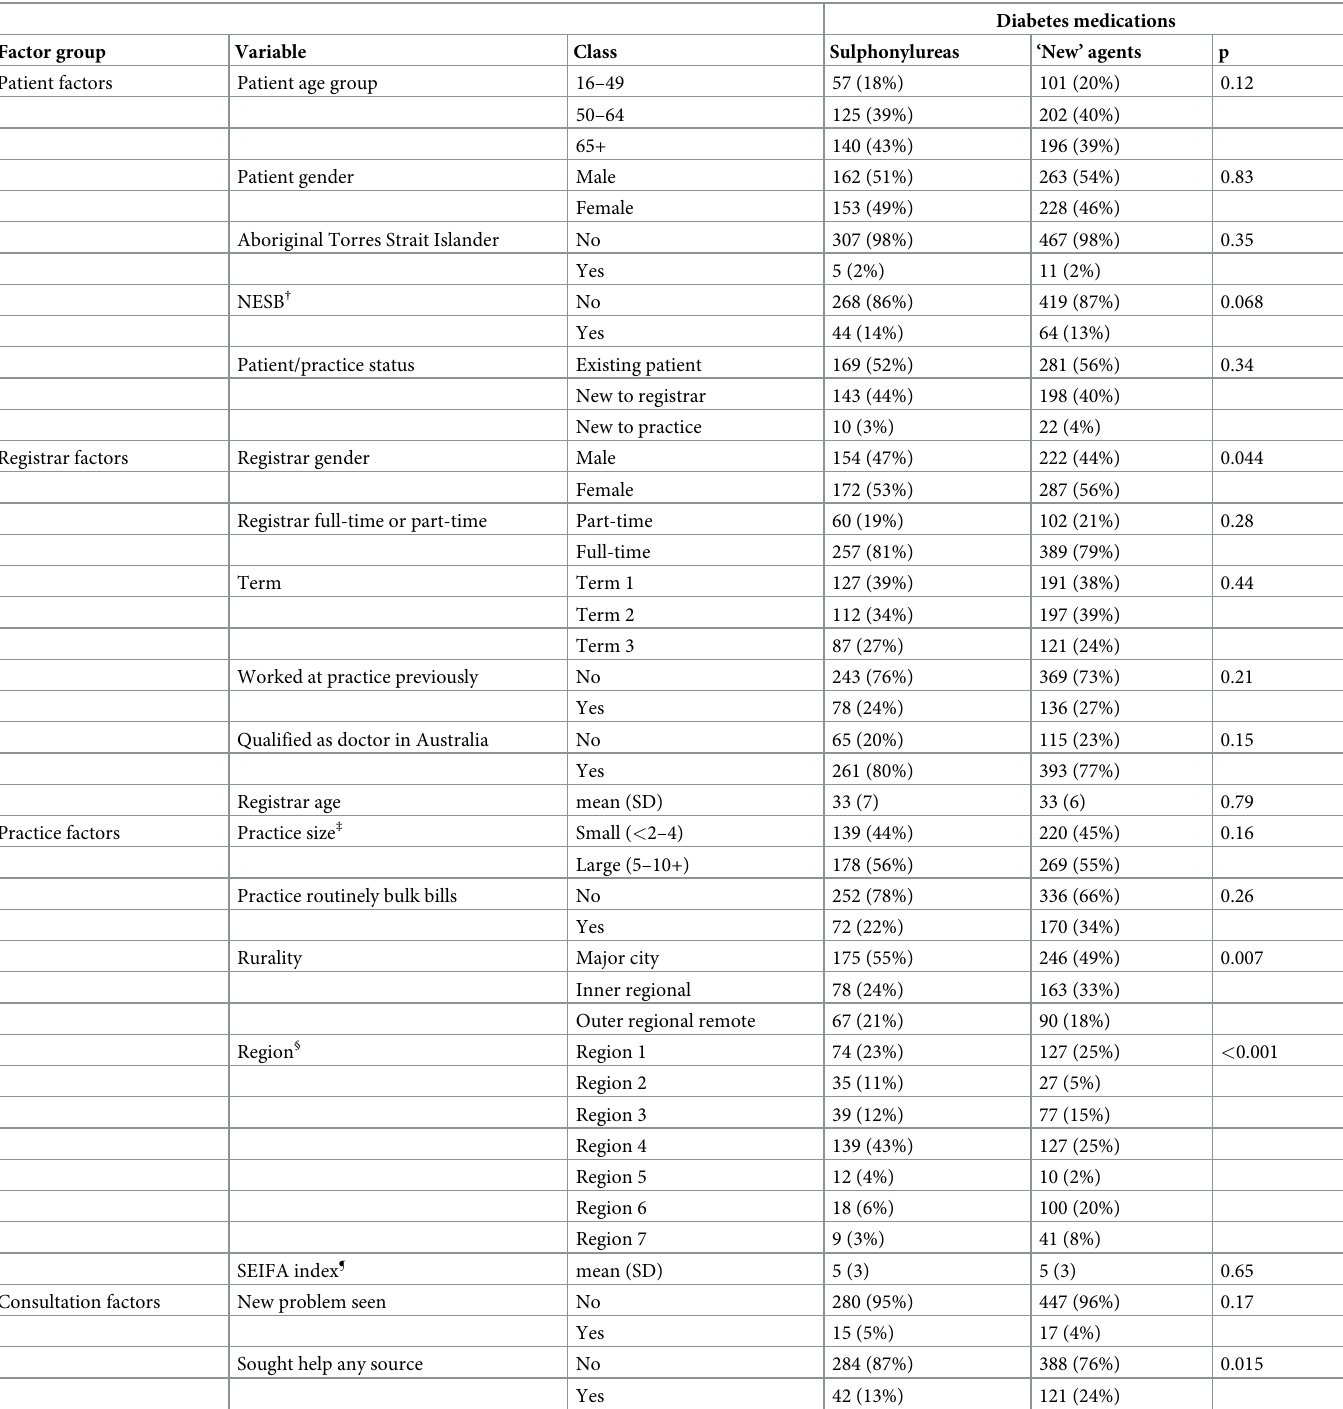
Table 2. Characteristics associated with prescribing medications for T2DM (adjusted by